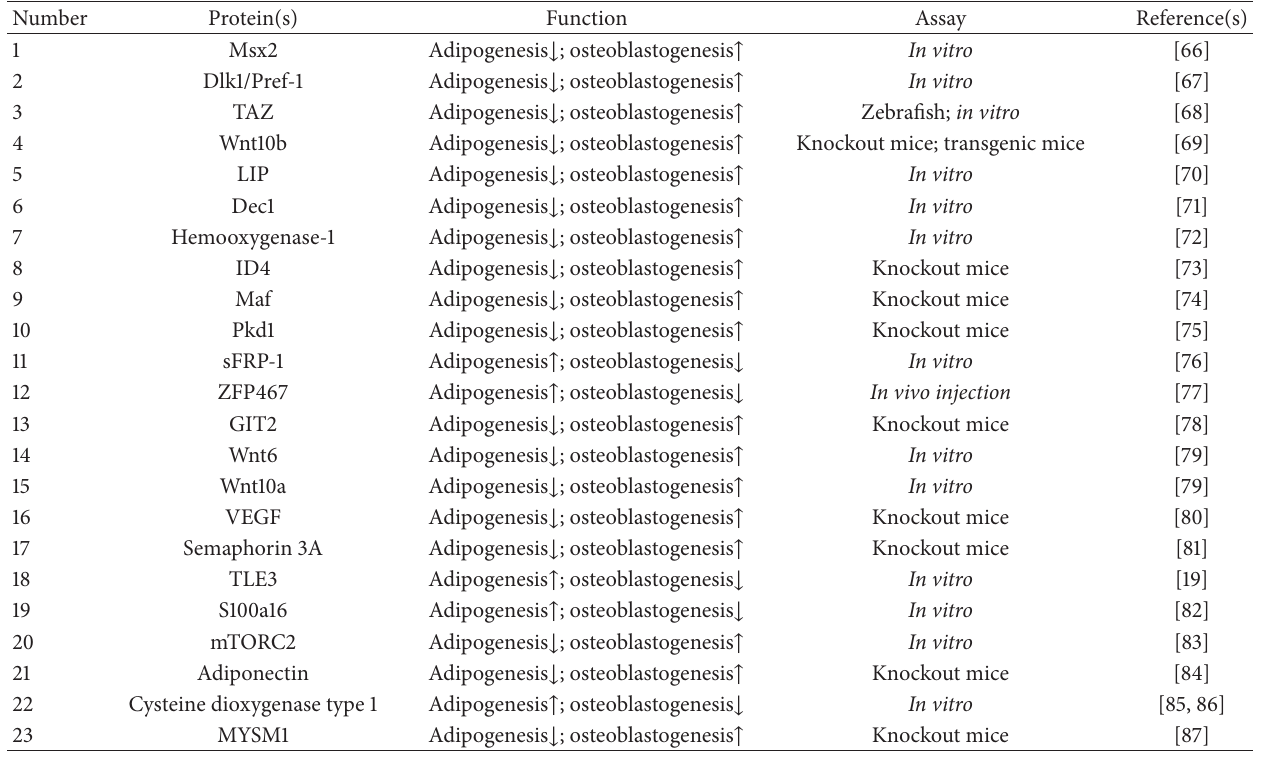
Table 1: The proteins regulate adipogenesis and osteoblastogenesis.